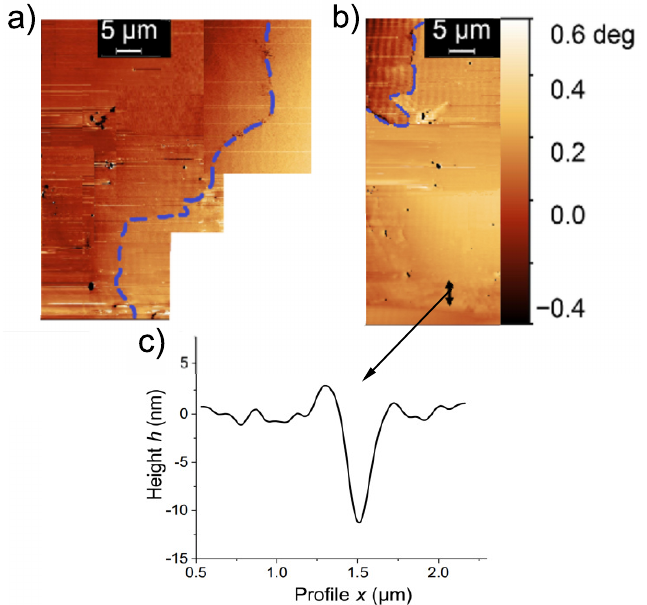
Figure 6. MFM phase images of a region around the current path (dashed blue line) before ( a ) and after the scratch ( b ). The black arrow in ( b ) marks the region of the scratch, which topography was measured with an AFM, see scan line profile in ( c